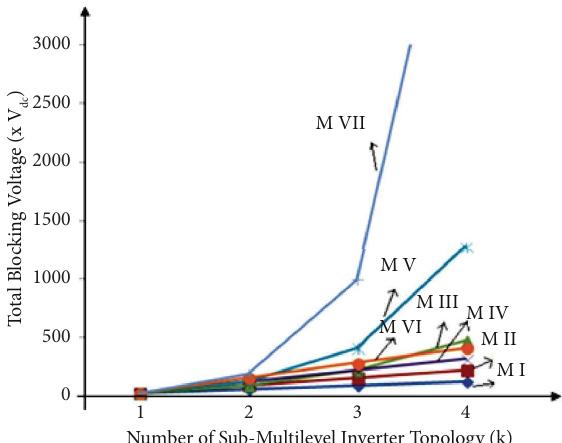
Figure 9: Variation of total blocking voltage with proposed submultilevel inverters.